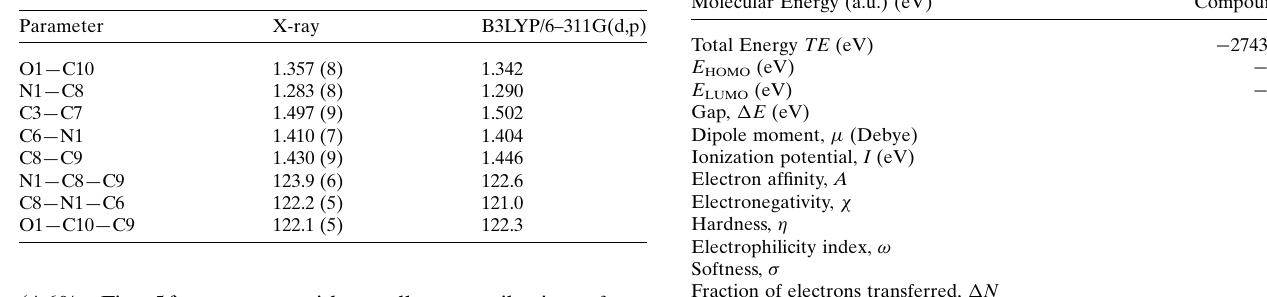
Table 2 Comparison of selected observed (X-ray data) and calculated (DFT) geometric parameters (A˚ , (cid:3) ) for (I).